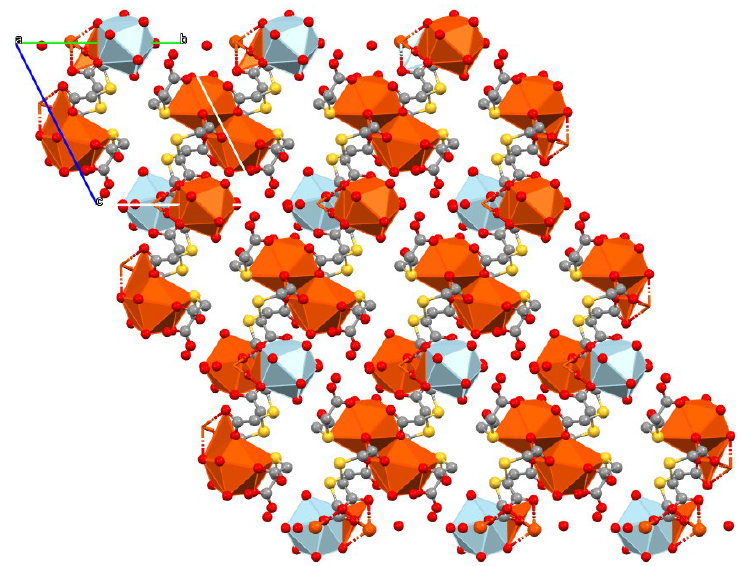
Figure 3. Packing of 1 in the bc plane. Polyhedra of Sm1 are colored orange, while Sm2 ones are light blue. Hydrogen atoms and crystallization water molecules are omitted for clarity.